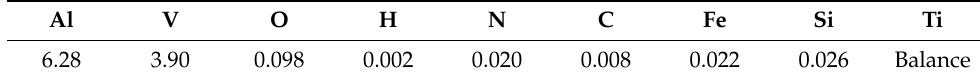
Table 1. Composition of Ti-6Al-4V alloy powder (wt.%).